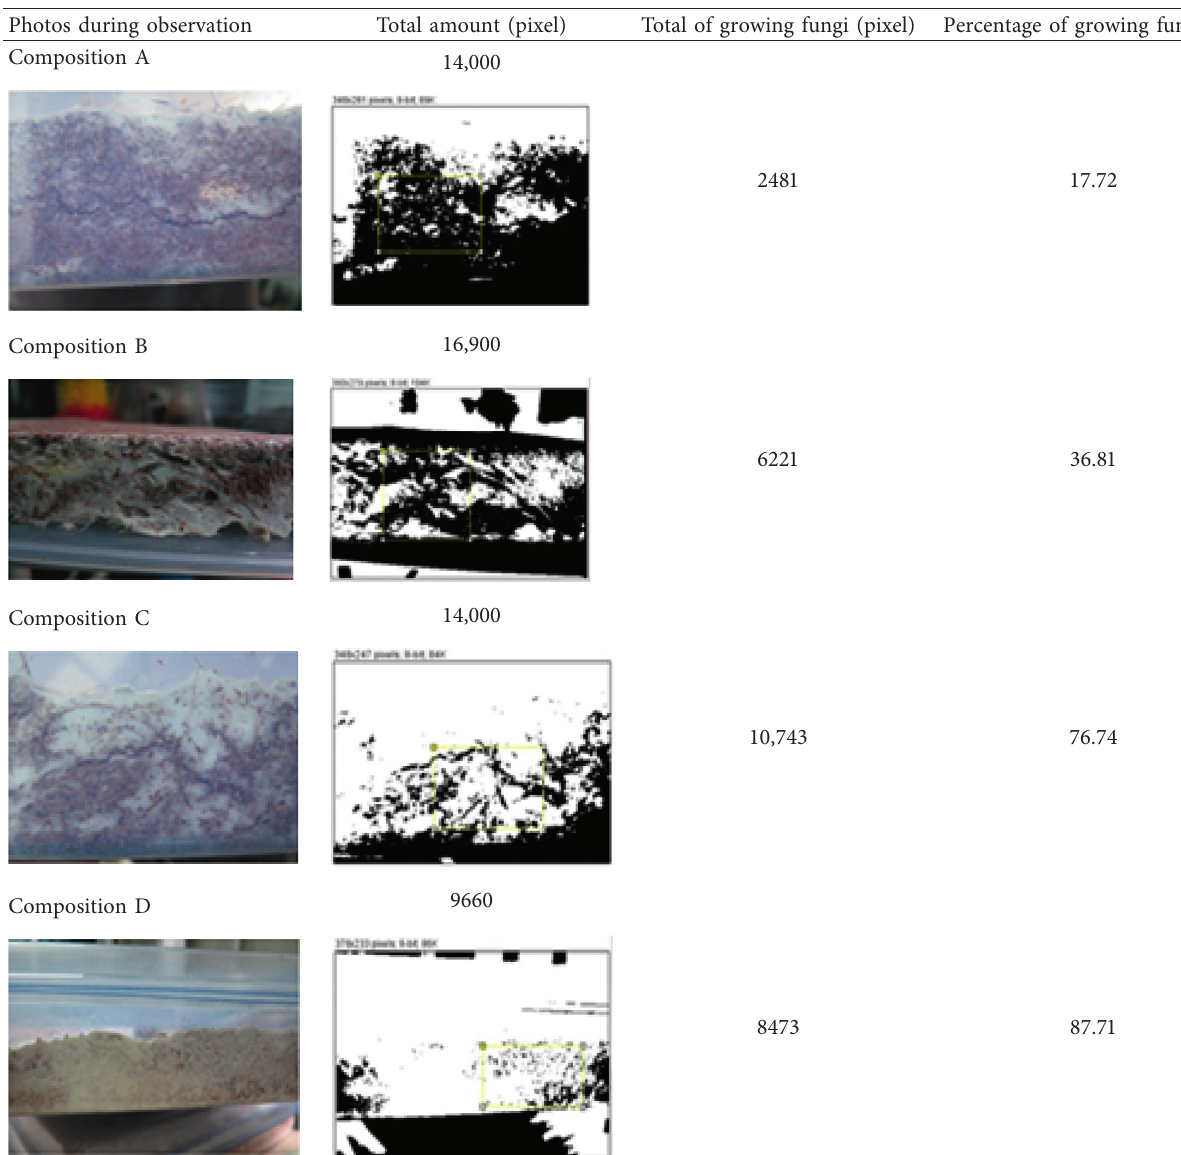
Table 4: Percentage of mycelium growth ratio in